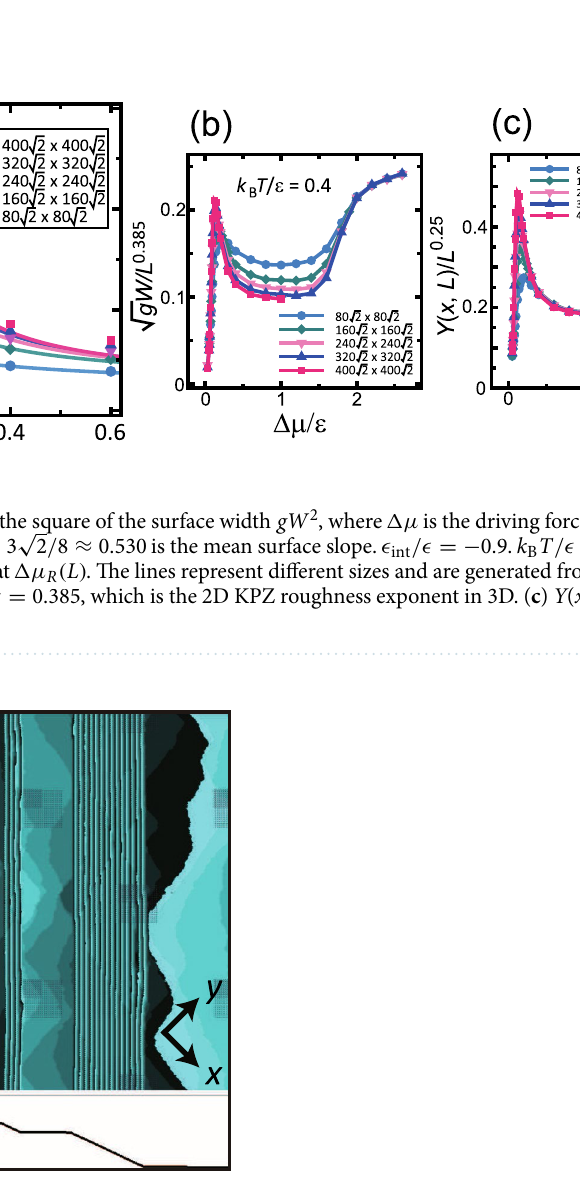
Figure 2. Typical morphology of a faceted-rough surface: snapshot generated by the Monte Carlo method 10 8 MCS/site. k B T /ǫ 0.4 . �µ/ǫ 0.08 . ǫ int /ǫ 0.9 . Size: 400 √ 2 a at 4 × = = = − p N step a / L 3 √ 2 / 8 0.530 . l d (mean equal distance between 2D nuclei 63 ), l c , and t d are 28 a , 13 a , and ¯ = = ≈ 1.44 10 3 MCS/site (Eq. (4)). Inset: Illustration of a step-detachment mode in a poly-nucleation process at the × edge of a faceted